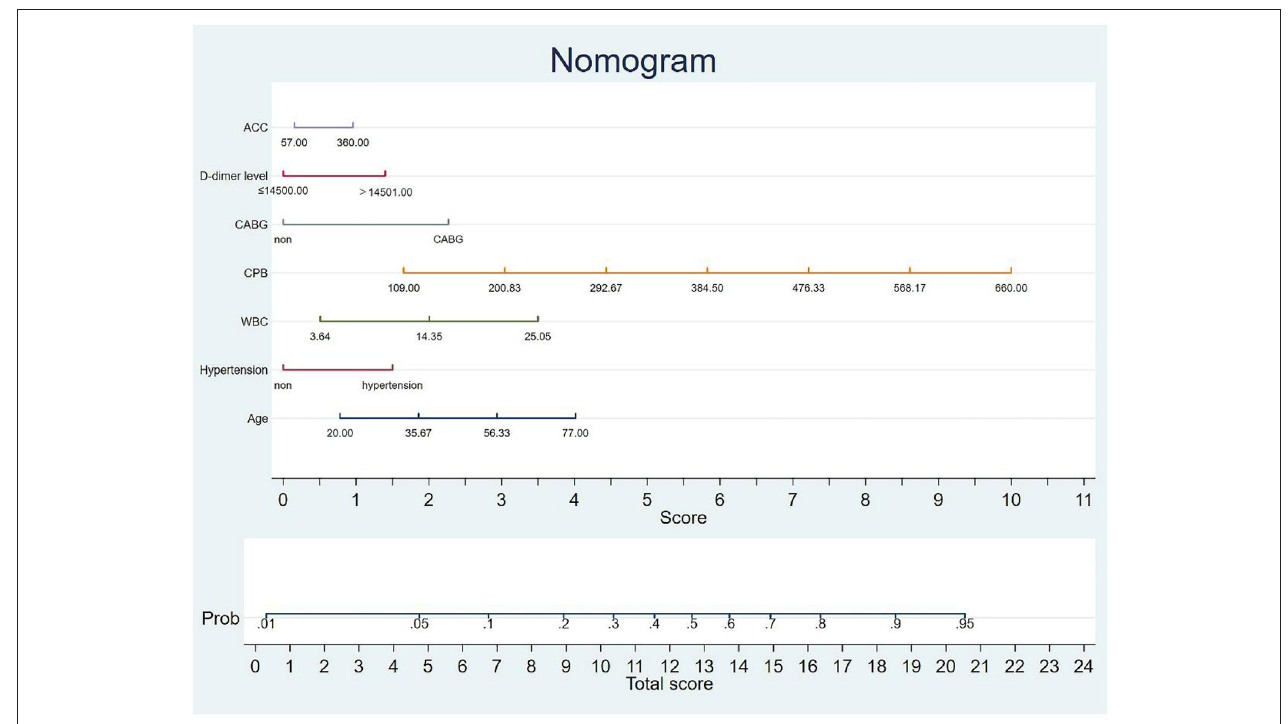
FIGURE 4 | Nomogram for